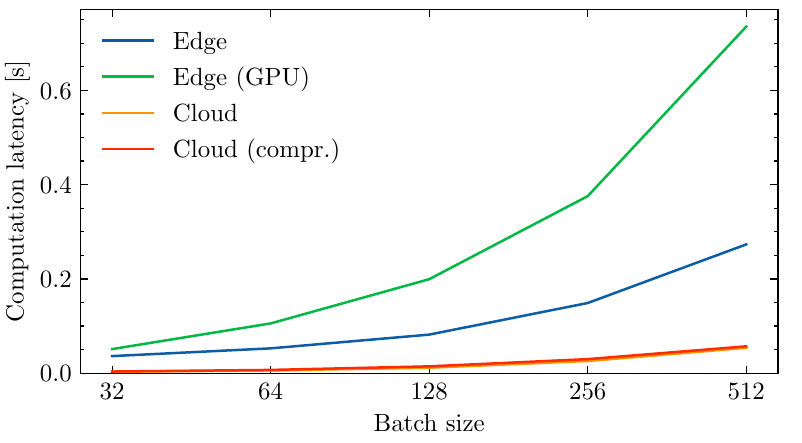
Figure 8. The mean computation latency is higher for edge computing than for cloud computing. As expected, enabling compression does not affect computation